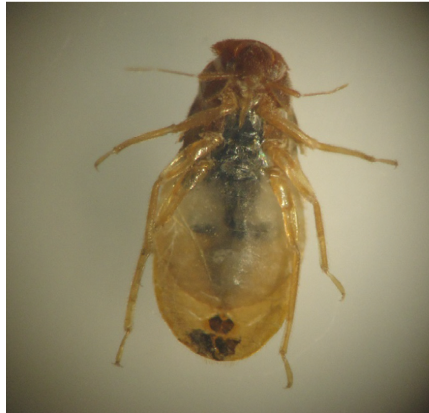
Figure 2: Nymph showing incomplete molt after taking an iver- mectin blood